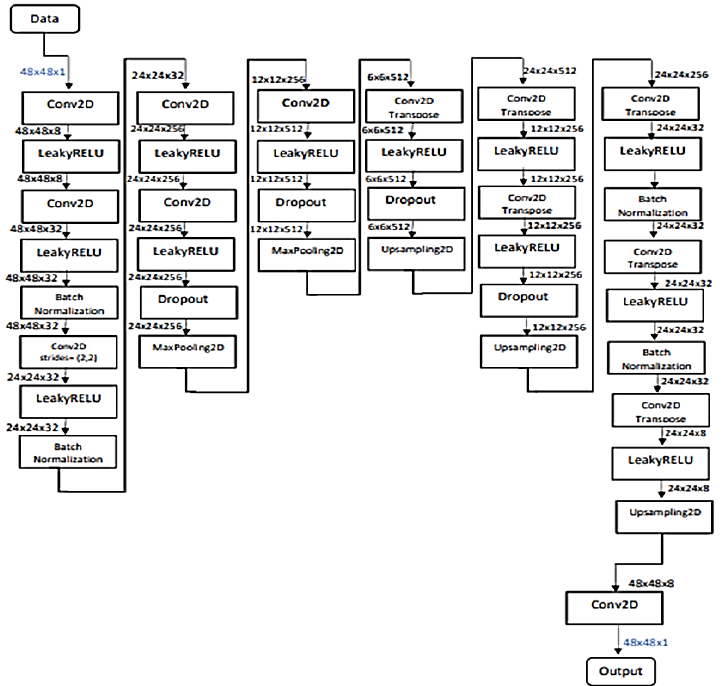
Figure 5. The architecture of the proposed autoencoder. Each column of hidden layers represents a bigger layer.